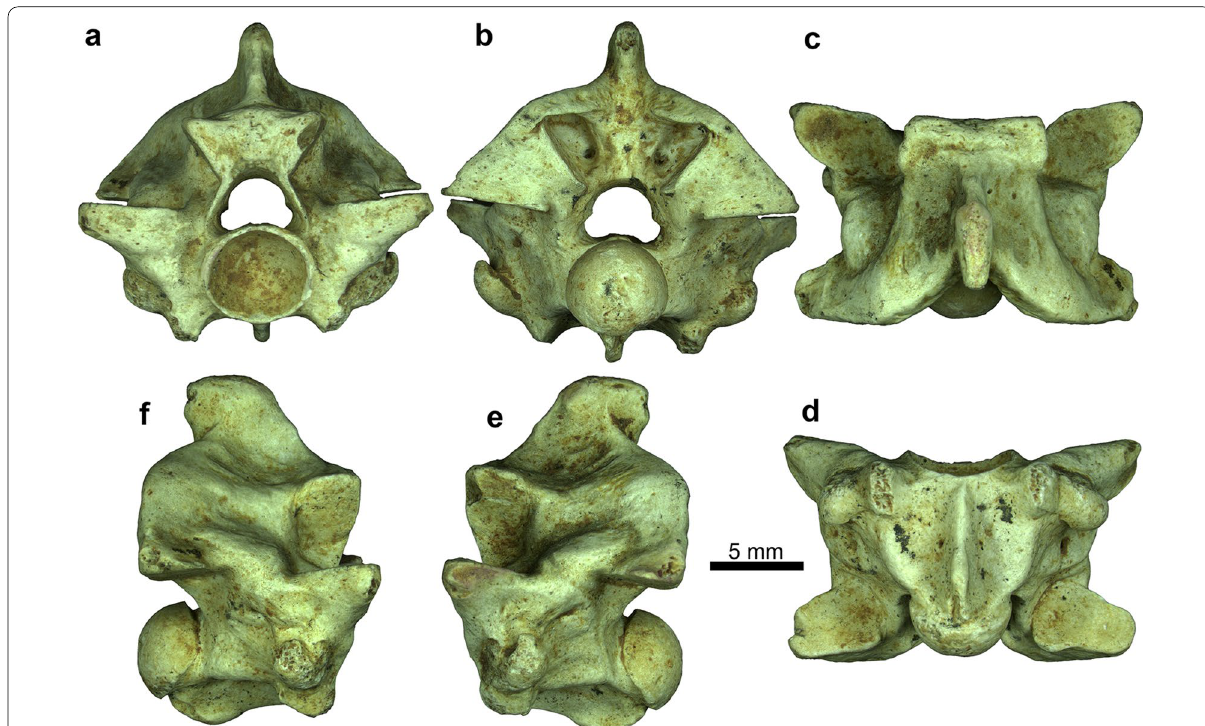
Fig. 10 Palaeopython cadurcensis from an imprecisely known locality in the Phosphorites du Quercy: anterior to anterior mid-trunk vertebra (NHMW 2019/0033/0037) in anterior ( a ), posterior ( b ), dorsal ( c ), ventral ( d ), left lateral ( e ), and right lateral ( f )